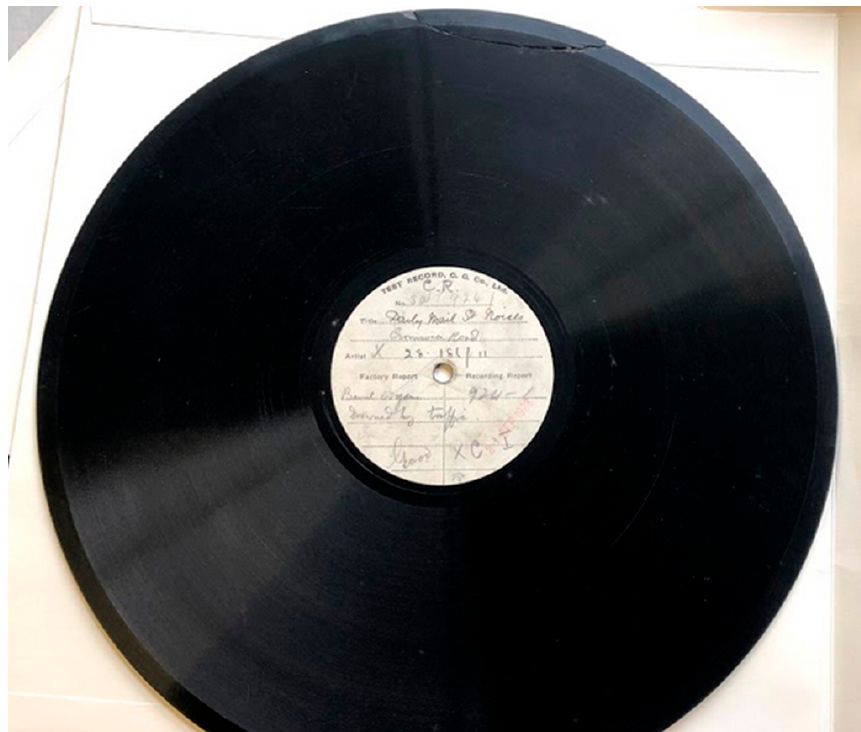
Figure 2. Cromwell Road LSN record.